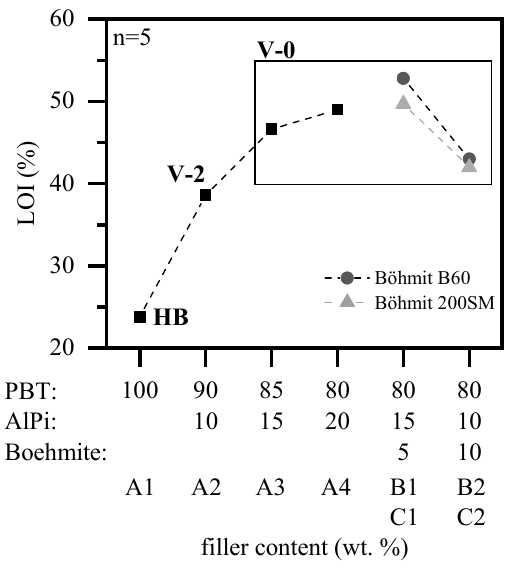
Figure 4. Oxygen index and UL-94 classification of AlPi and boehmite modified PBT.